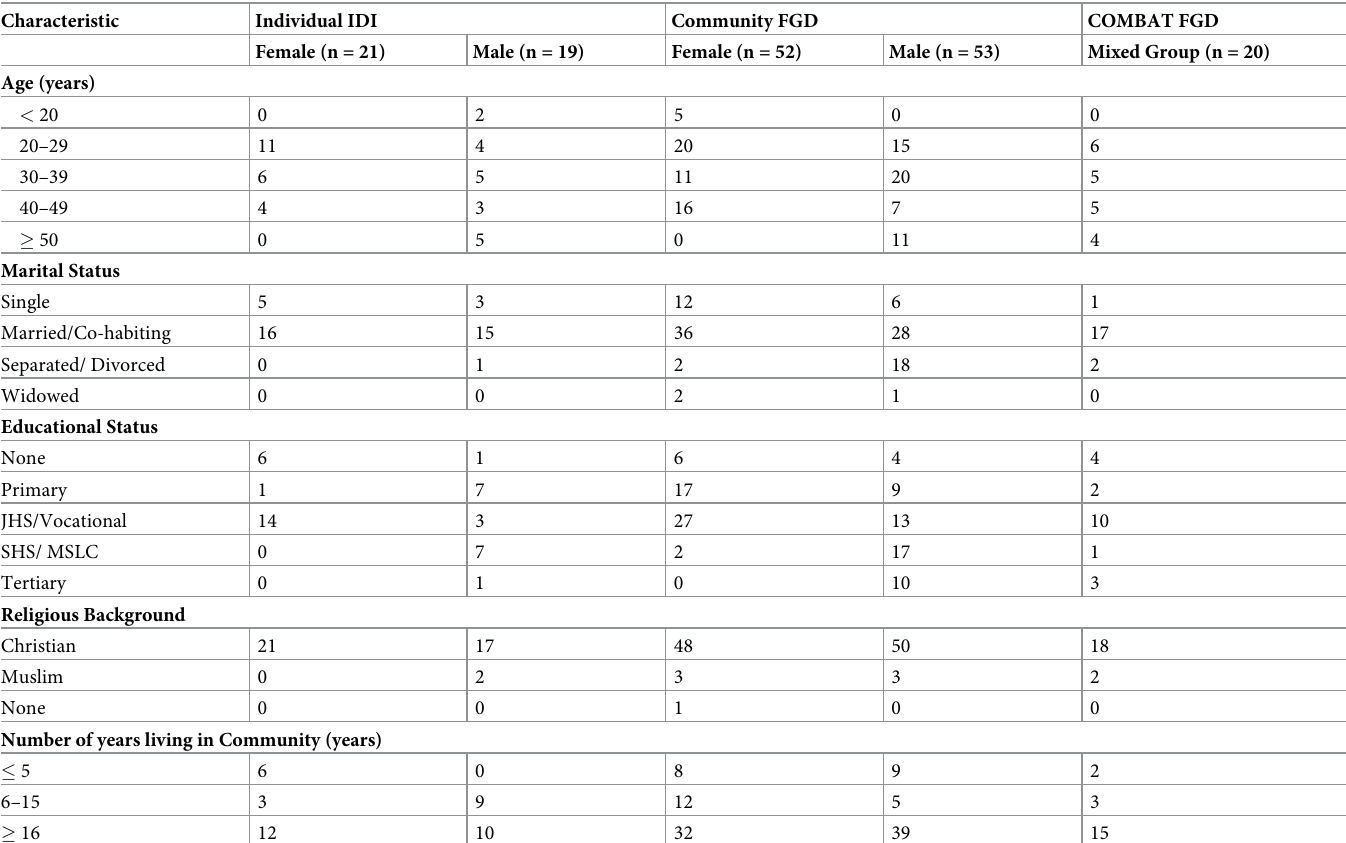
Table 1. Socio-demographic characteristics of